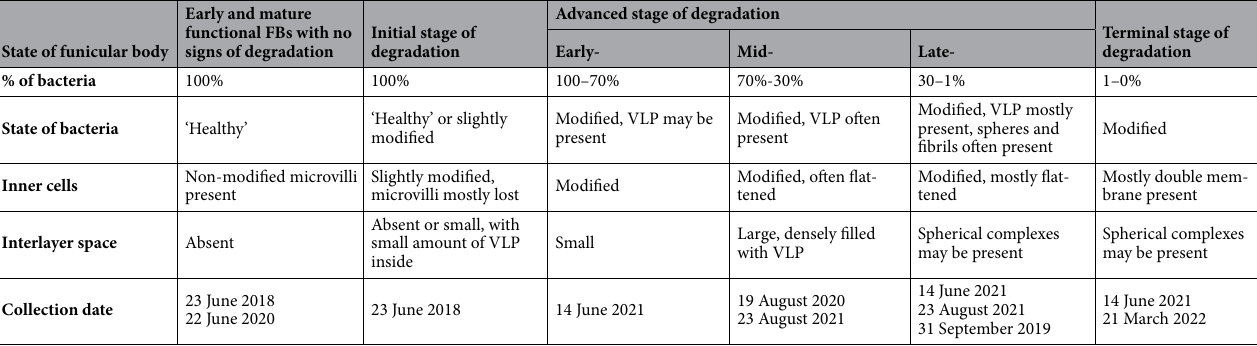
Table 1. State of the funicular bodies (FB) and bacteria, and the presence of the virus-like particles (VLP) in the colonies of Dendrobeania fruticosa collected in different